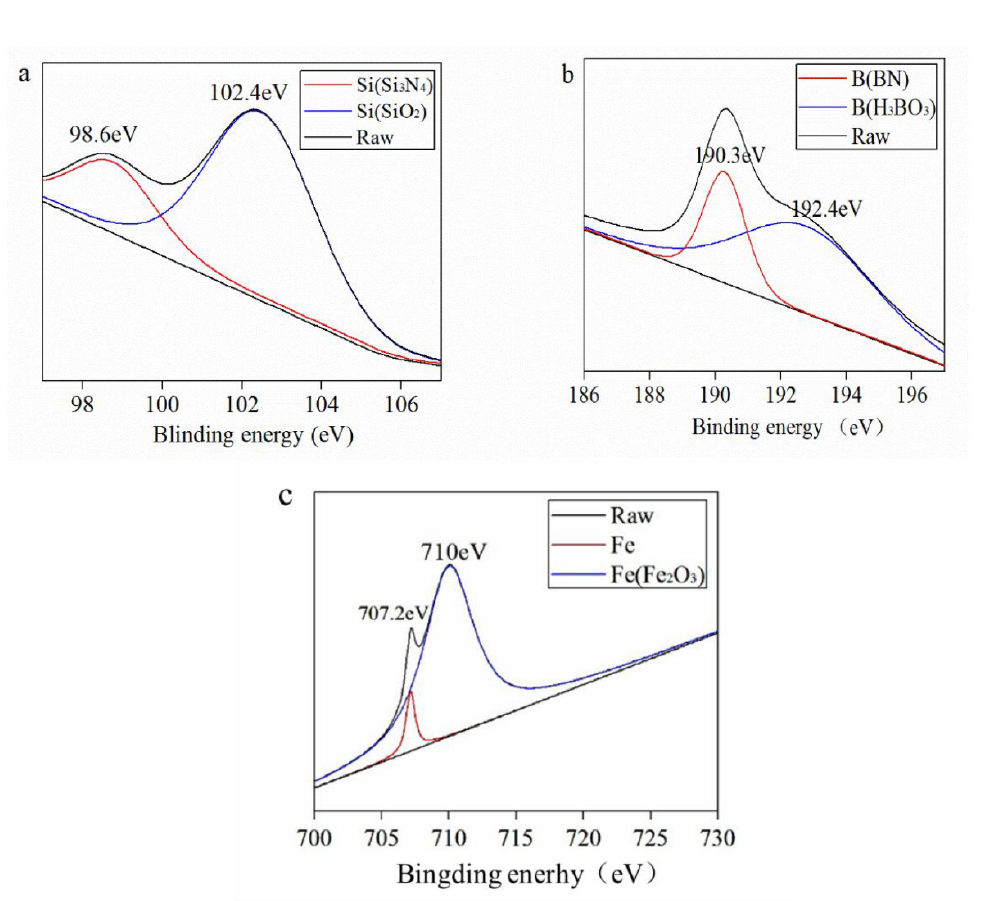
Figure 7. X-ray photoelectron spectroscopy (XPS) spectrum of Si 2p ( a ), B 1s ( b ), and Fe 2p 3/2 ( c ) on the worn surface of the GCr15 disc sliding against the SN10 pin under dry friction conditions.